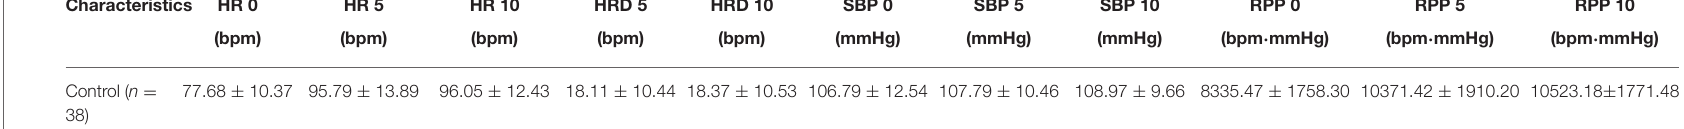
TABLE 3 | Comparison of HUTT parameters for control group and POTS group (Mean ± SD). Characteristics